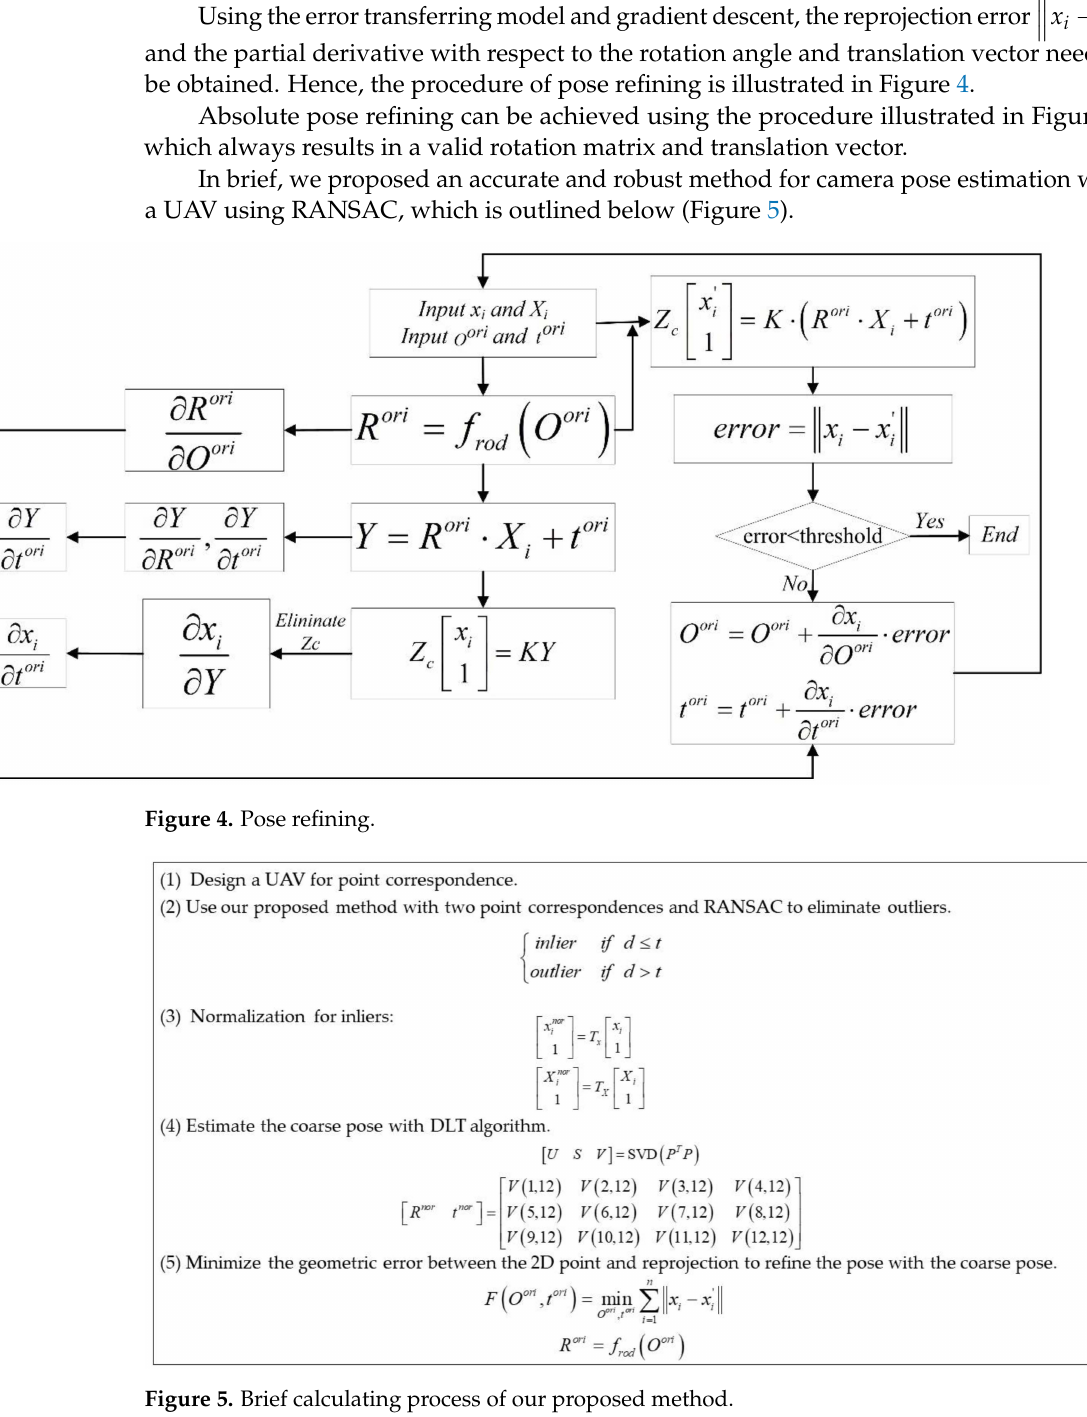
Figure 5. Brief calculating process of our proposed